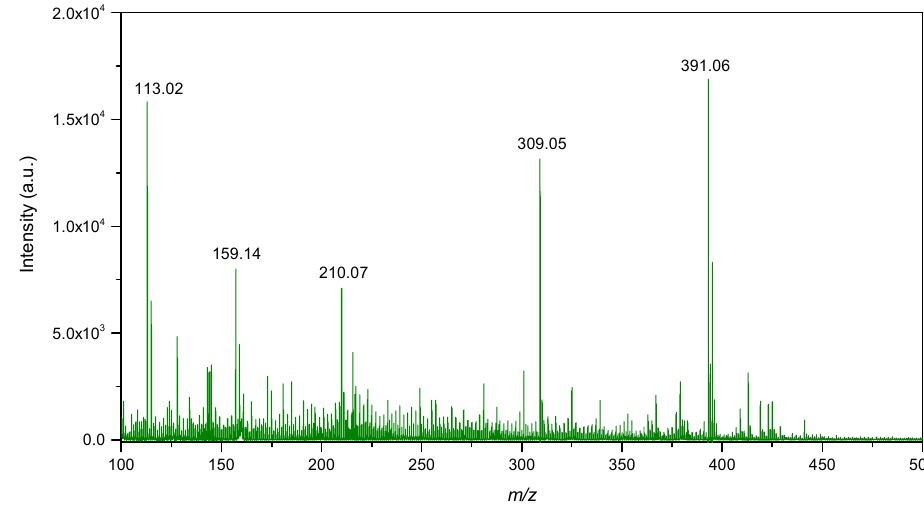
Figure 10. LDI-MS spectra of IONPs in the low mass region.